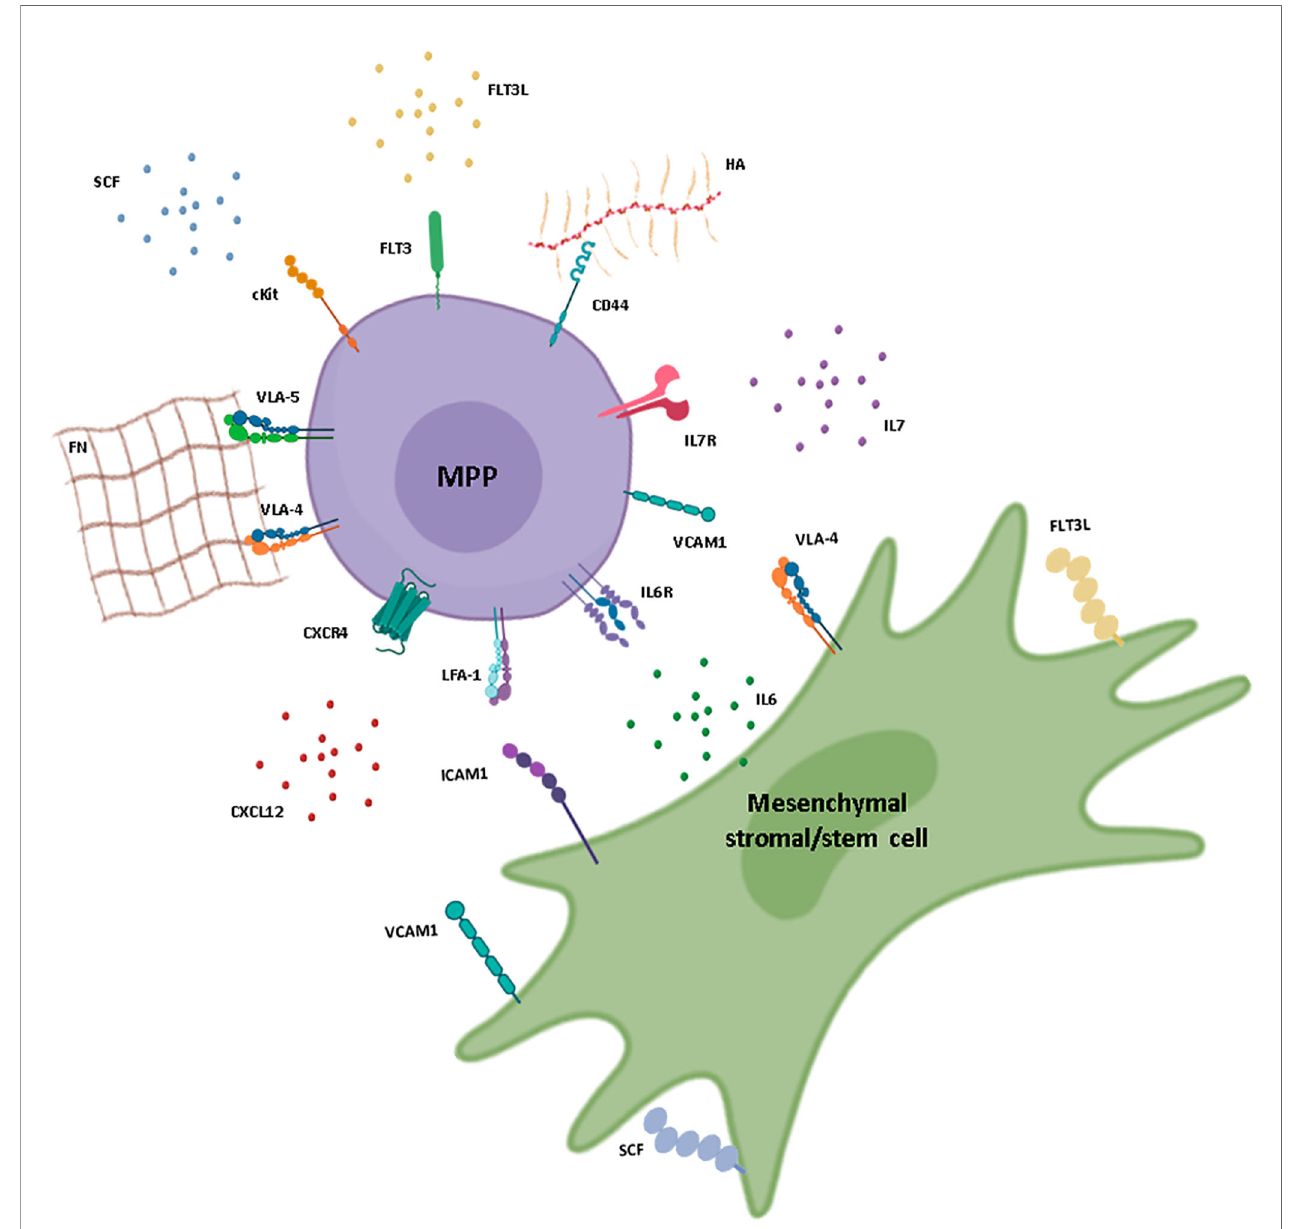
FIGURE 1 | Interactions between hematopoietic multipotent progenitors and mesenchymal stromal/stem cells in the BM. Schematic representation of a multipotent progenitor (MPP) in its BM environment and the possible interactions established with a mesenchymal stromal/stem cell (MSC). Membrane receptors, adhesion molecules, and soluble niche factors previously described for hematopoietic stem and progenitor cell (HSPC) maintenance in the BM are represented. CXCL12, IL-7, IL-6, and SCF are mainly produced by the MSC and bind to CXCR4, IL-7R, IL-6R, and cKit, respectively, at the surface of the MPP. MSCs also produce proteins of the extracellular matrix, such as fi bronectin (FN) and hyaluronic acid (HA), which promote cell adhesion through integrin receptors and adhesion molecules expressed by the progenitor cells, such as VLA-4, VLA-5, and CD44. Interactions in the form of cell-cell contacts are also represented and involve VCAM-1 and VLA-4, expressed by both cell types, as well as LFA-1 expressed by MPPs and ICAM-1 expressed by perisinusoidal stromal cells, pericytes, and osteoblasts. Stromal cell factor (SCF) and FLT3L can be found as both soluble and membrane-bound forms. FLT3L is produced mainly by fi broblasts within the BM. IL, interleukin; ILR, interleukin receptor. Figure created using the BioRender icon